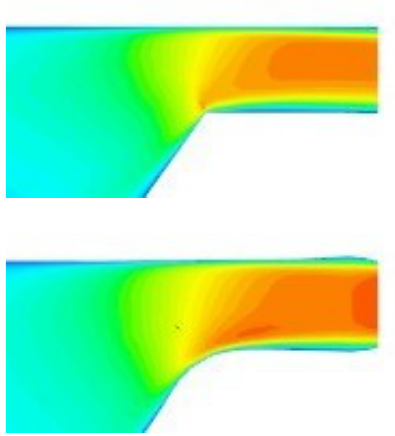
Fig. 6. Nozzle original (upper) and optimized shape - velocity flow field - detail